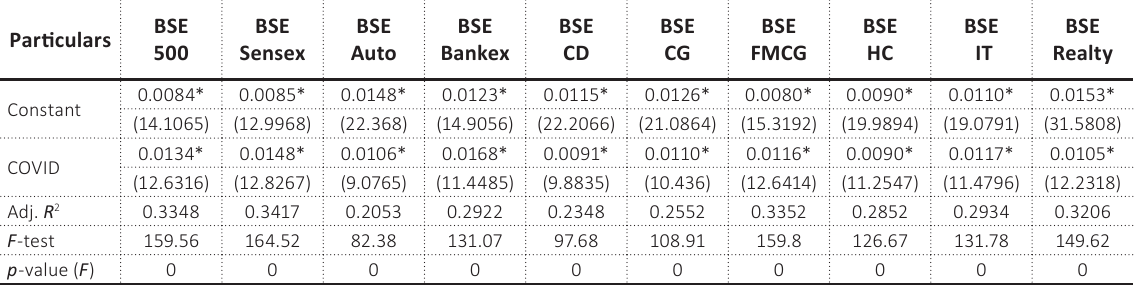
Table 4. Regression analysis: model 1 – for COVID-19 and standard deviation of the index returns Particulars